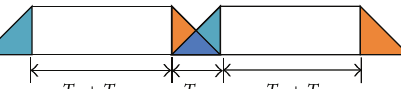
Figure 4: CMMB symbol overlapping.